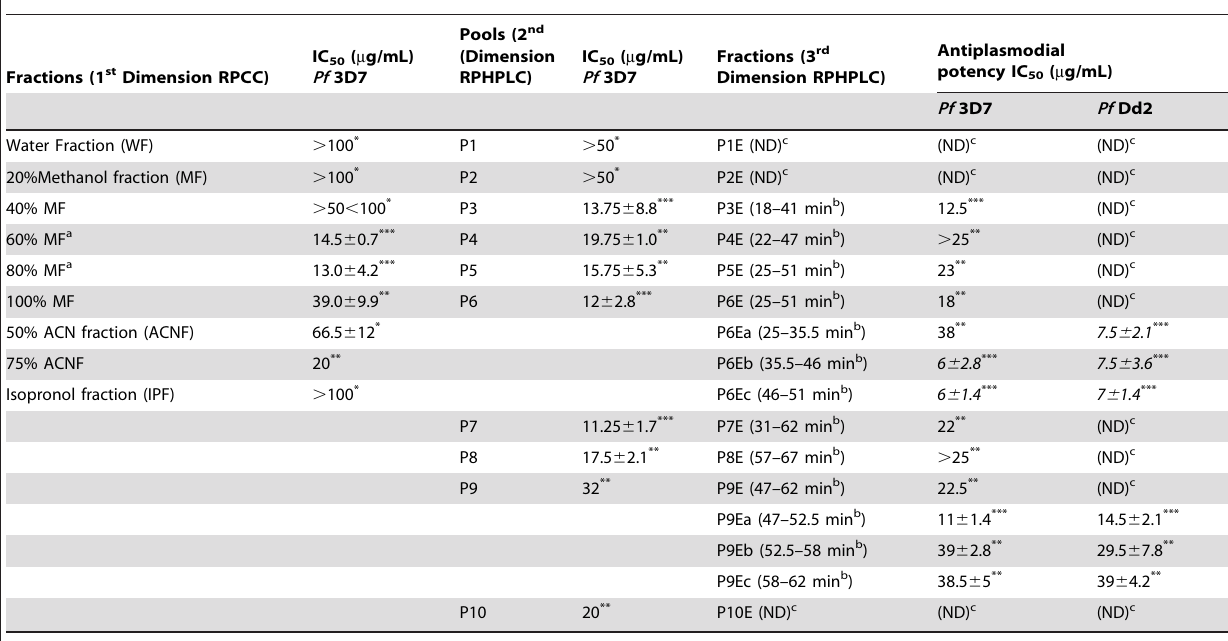
Data shown are expressed as the mean of triplicates 6 SD. Potencies for active fractions (IC 50 , 8 m g/mL) are shown in italics. a Fractions which were combined together, b Time boundaries given correspond to the vertical lines shown in each chromatogram of Fig. 3B, c not done. ACN: Acetonitrile, RPCC- Reverse phase glass column chromatography. CQ (100 nM, 1000 nM) were used as positive controls for Pf 3D7 and Pf Dd2 respectively. For details of chromatographic separations, see Materials and methods and Figures 1 and 3. Symbols used for varying antiplasmodial potency are *** (Promising